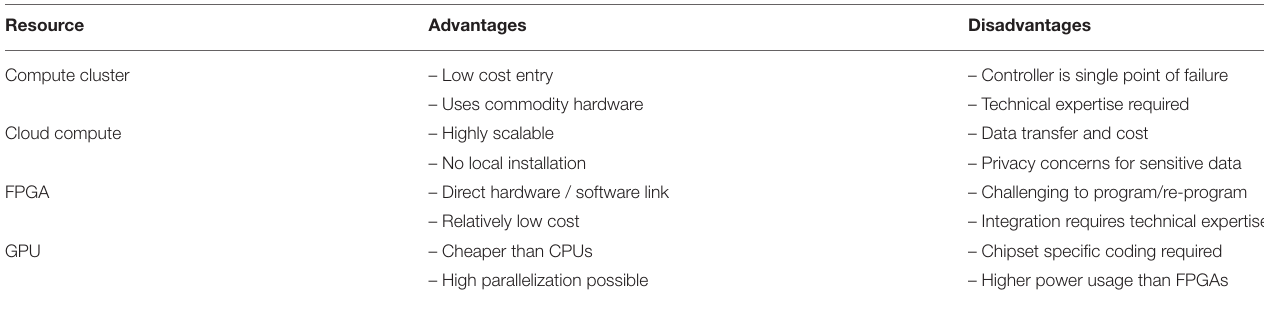
TABLE 3 | Hardware based